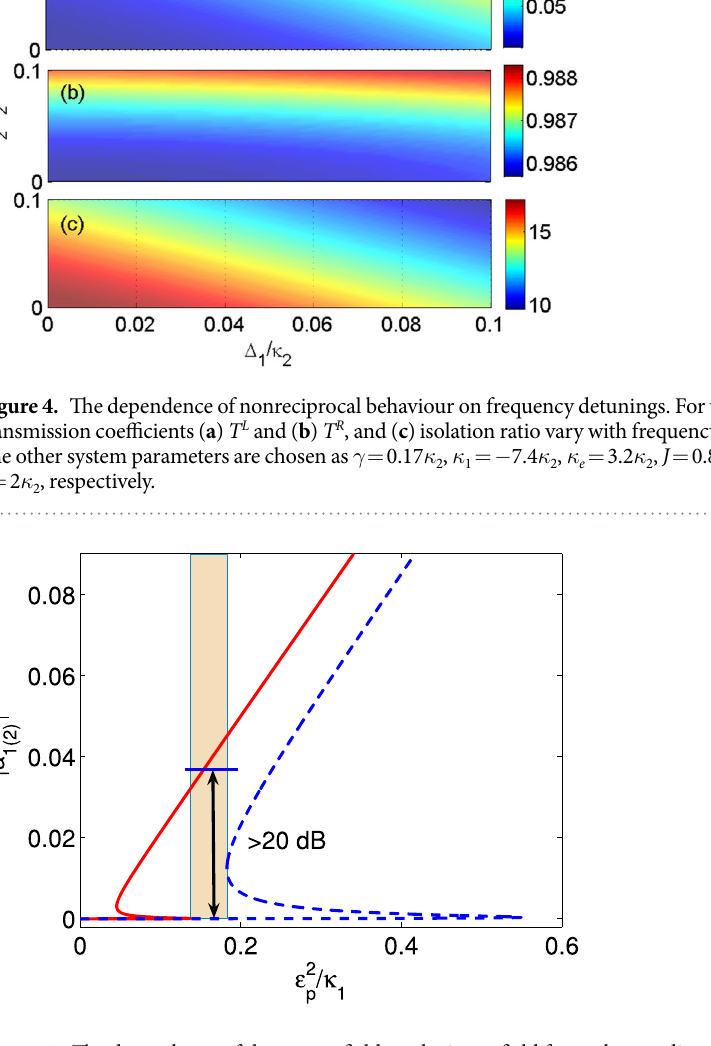
2 for the resonant case. The parameters are γ = 0.1 κ 1 , p 2